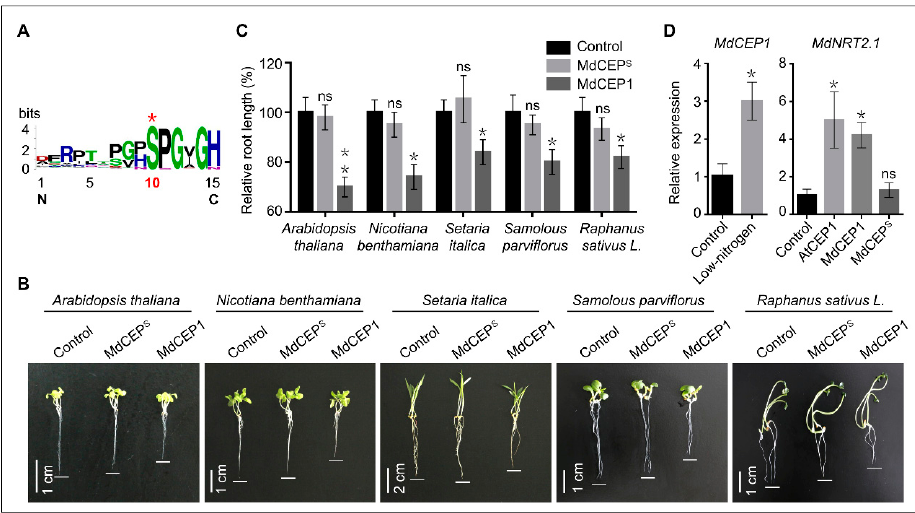
Figure 8. The serine is evolutionarily conserved in 32 higher land plants. ( A ) The evolutionarily conserved amino acid of CEPs in higher land plants. A WebLogo representation of the sequence of 273 CEP domains in 32 plant species. ( B ) Inhibitory effects of exogenous MdCEP1 and MdCEP S on growth of Arabidopsis thaliana , Nicotiana benthamiana , Raphanus sativus L., Gramineae ( Setaria italica ) and Setaria italica ( Brassica campestris L.). These sterile seeds were plated on MS medium with MdCEP1 or MdCEP S and grown for 2 weeks. Arabidopsis thaliana was used as the positive control to detect the activity of the synthesized MdCEP1. ( C ) Relative primary root length of the higher land plants shown in ( B ). Error bars indicate SEM ( N = 3, n =30). * p < 0.05; ** p < 0.01 (Student’s t -test). ns, no significance. ( D ) The relative expression levels of MdCEP1 in 14-day-old apple seedlings treated with 0.5 mM nitrates. And the relative expression levels of MdNRT2.1 in 14-day-old apple seedlings treated with AtCEP1, MdCEP1 or MdCEP S . Error bars indicate SEM ( N = 3). * p < 0.05 (Student’s t -test). ns, no